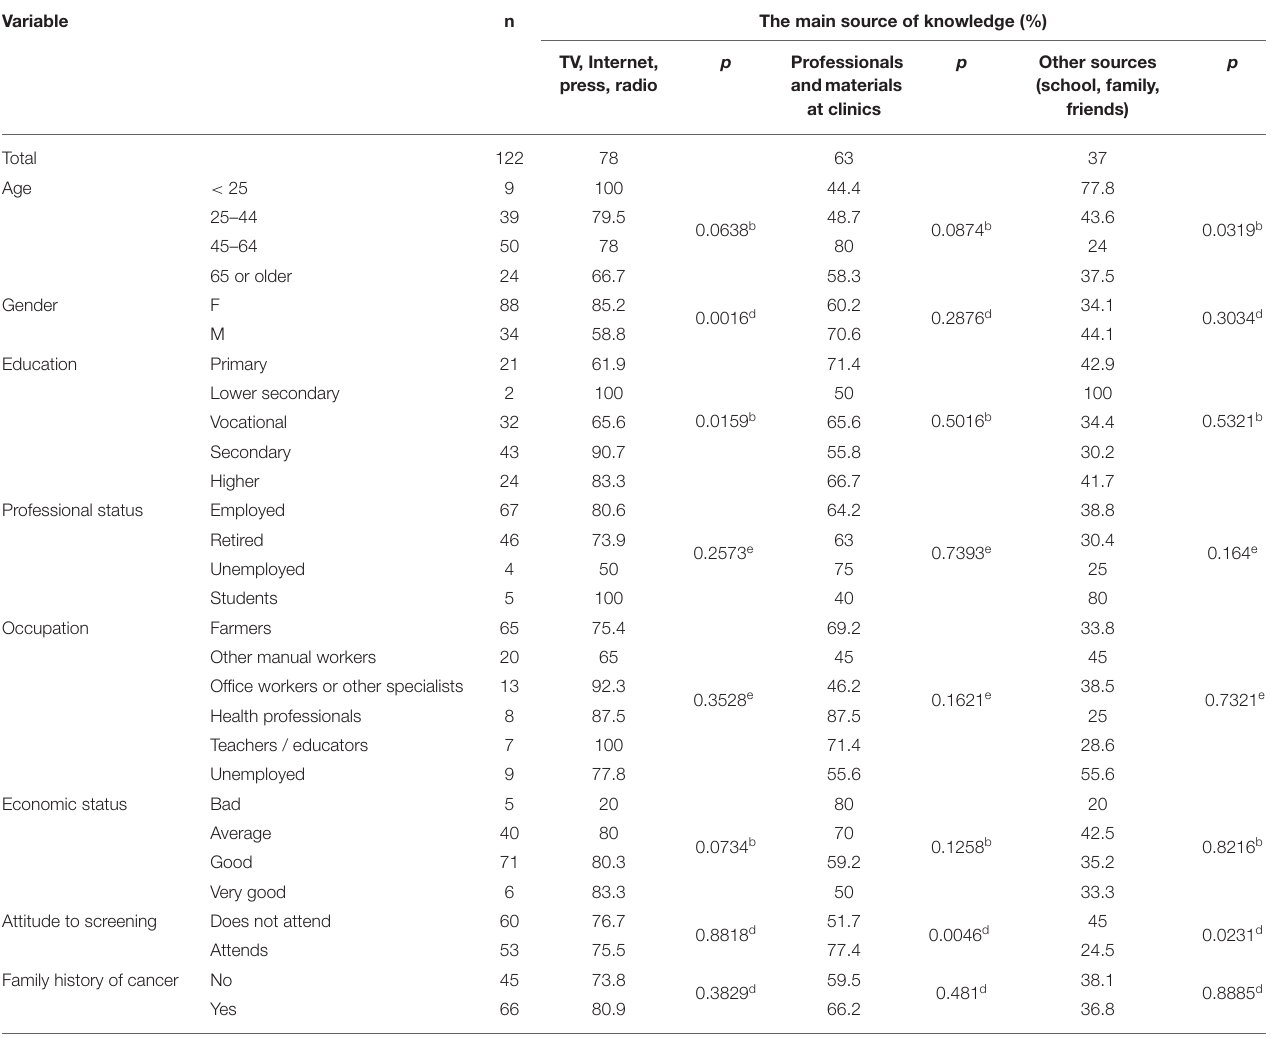
TABLE 4 | The sources of health knowledge ( n = 122).